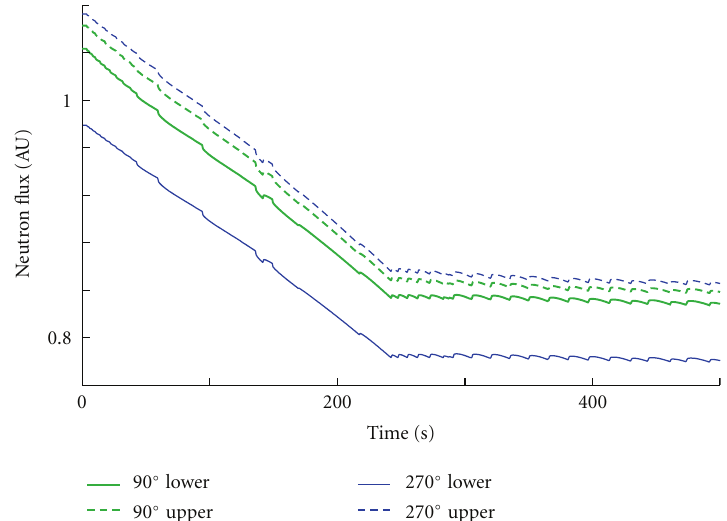
Figure 11: Indication of four ex-core ion chambers during a postulated 100%–80% ramp. Due to the spatial neutronics and moderator temperature distributions, the readings may di ff er substantially, and the control system has to make decisions using this information.